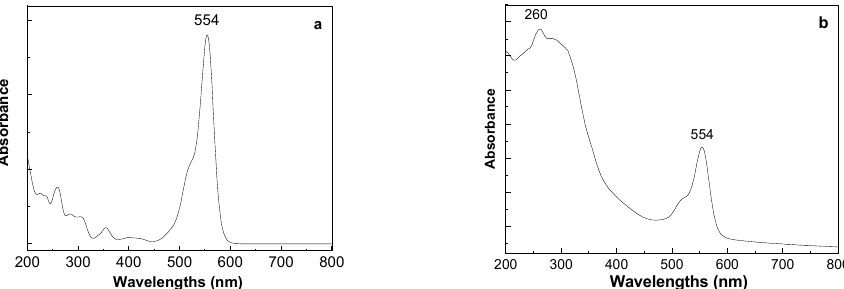
Figure 10. The UV–VIS spectra of the RhB aqueous solutions alone ( a ) and containing DWNTs ( b ). The detailed evolution of RhB degradation in aqueous solutions containing the T, S2,